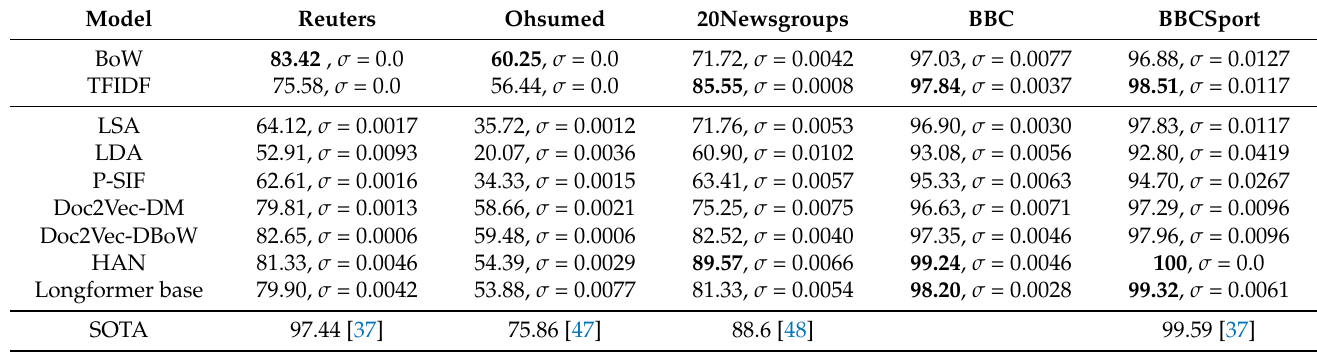
Table 1. Averaged overall classification accuracy (in percent); cross-validation for Ohsumed, BBC and BBCSport, test–train split for Reuters and 20Newsgroups. The maximum length of input data for HAN was set at 30 utterances 300 words each. Numbers in bold denotes results better than BoW and TFIDF or the best overall result.